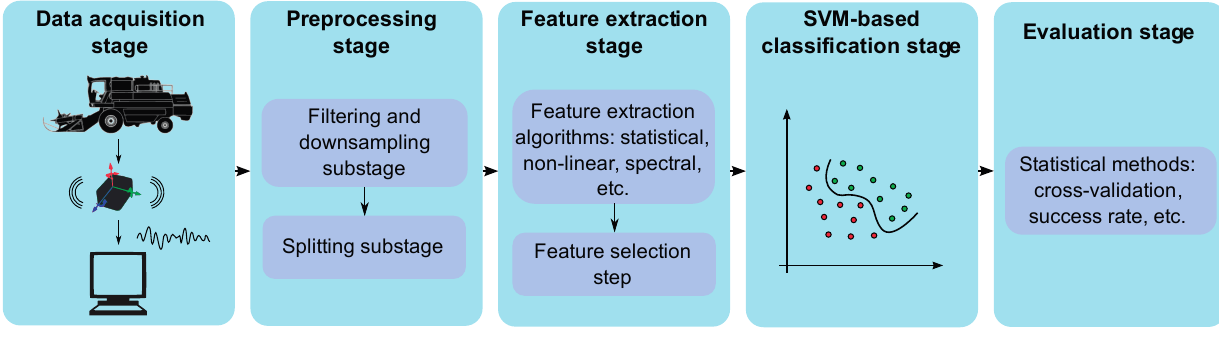
Figure 4. Overall block diagram summarizing the main processing